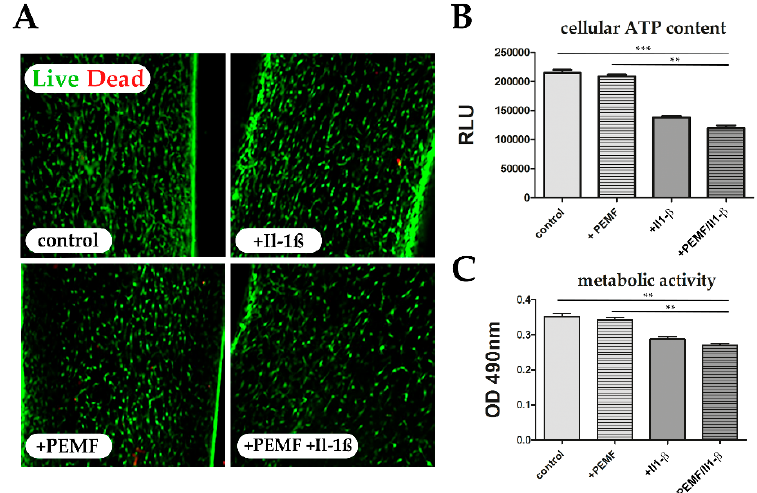
Figure 1. Experimental setup for high energy pulsed electromagnetic field (PEMF/rPMS) treatment of tendon-like constructs. ( A ) Tendon derived stem progenitor cells were isolated from 3 months old female F344 rats ( n = 3) and used for the generation of 3D tendon-like constructs. Four different treatment groups were established: an untreated control group, a +Il-1 β treated group, a +PEMF treatment group and a +PEMF+Il-1 β treatment group. After PEMF treatment regimen total RNA of the 4 treatment groups was isolated for RNASeq analysis. ( B ) Image of tendon-like constructs after 7 days of contraction. ( C ) Position of tendon-like constructs in PEMF coil during treatment.